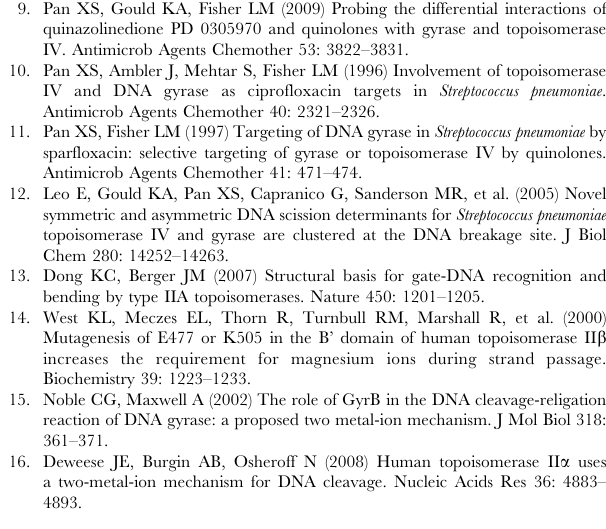
Figure S1 Schematic model of the DNA transport mechanism employed by a type II DNA topoisomerase and its inhibition by antibacterial/anticancer drug action. The diagram is built using a model of the full-length topo IV which, in turn, is based on the crystal structure of the drug-free cleavage complex of topo IV from S. pneumoniae with cleaved DNA (reported in this paper, 3KSA, covering the N-terminal domain of ParC, C-terminal domain of ParE and bound/cleaved G-segment) as well as the crystal structures of the C-terminal domain of GyrA from B. burgdorferi (1SUU) 1 (for C-terminal domain of ParC) and the N-terminal domain of GyrB from E. coli (1EI1) (for N-terminal domain of ParE) 2 . Unbound G-segment and the transported T-segment were generated using WinCoot 3 . N-terminal domain of ParC is shown in blue, C-terminal domain of ParC is in cyan, N-terminal domain of ParE is in purple, C-terminal domain of ParE is in yellow, G- segment is in green and T-segment is in red. D L stands for a change in the linking number of the DNA per cycle. An animated version of this scheme is available as the Supporting Movie S1 online. Figure S2 Key interactions within drug-stabilized cleavage complexes of S. pneumoniae topoisomerase IV. The cleavage complexes are stabilized by quinazolinedione PD 0305970 (A) and quinolone levofloxacin (B). The important inter-atomic distances are shown in A˚ ngstroms and indicated by arrows. Magnesium ion is in purple, tyrosine is in cyan, DNA bases are in green, DNA sugars are in grey, PD 0305970 is in yellow, levofloxacin is in ‘rose’ and water molecule is in light pink. Nitrogen, oxygen and phosphorus atoms are in blue, red and orange, respectively. Figure S3 Specifics of the G-segment binding groove and DNA curvature (stereograms). A, Key elements of the DNA-binding cleft of topo IV from S. pneumoniae . Residues within 5 A˚ distance from the DNA molecule are shown in surface representation. Side-